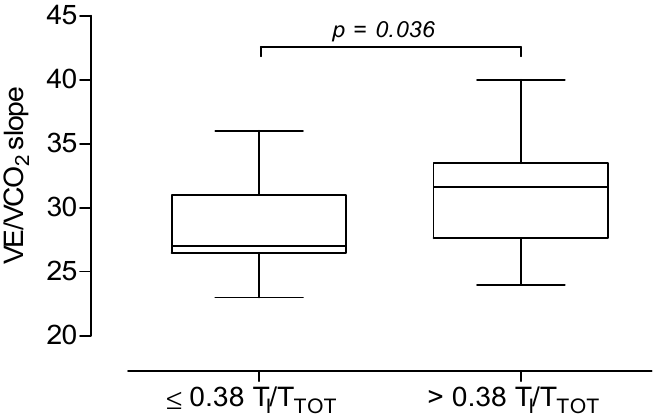
Figure 4. Mean, SD and range values of VO 2 peak ( upper panel ) and of VE/VCO 2 slope ( lower panel ) in 13 Long-COVID patients with T I /T TOT ≤ 0.38 and in 29 Long-COVID patients with T I /T TOT > 0.38 at peak of